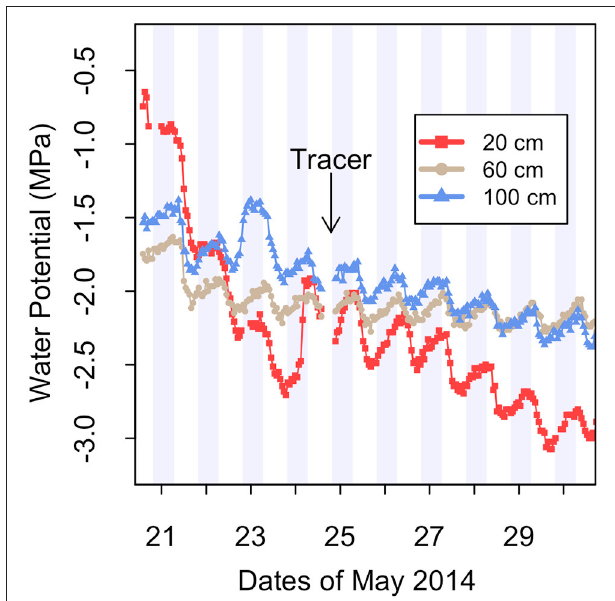
FIGURE 2 | Soil water potential measured by thermocouple psychrometers at three depths in crop + shrub subplot C. “Tracer” indicates the beginning of the stable isotope 2 H-tracer study on the evening of May 24. Gray shading represents night time hours. These data represent conditions beginning on day 13 of the imposed